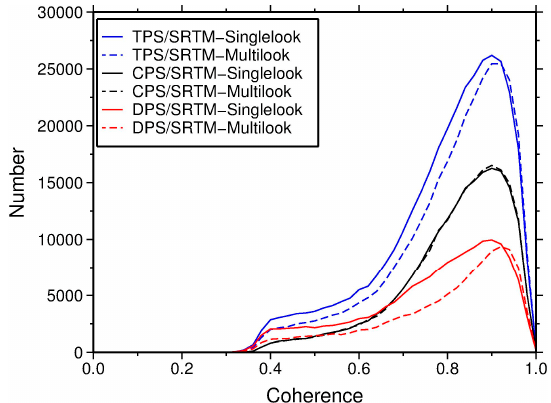
Figure 14. Coherence comparison between single-look geocoding and multi-look geocoding operation for TerraSAR-X with the external DEM SRTM-1arc. Blue, black and red solid lines represent the coherence histograms of TPS, CPS and DPS for single-look geocoding. Blue, black and red dashed lines represent the coherence histograms of TPS, CPS and DPS for multi-look geocoding. Two areas were selected to display the coordinate difference caused by external DEMs in Figure 15. Area 1 is a single building named Shenzhen convention and exhibition center (SZCEC)